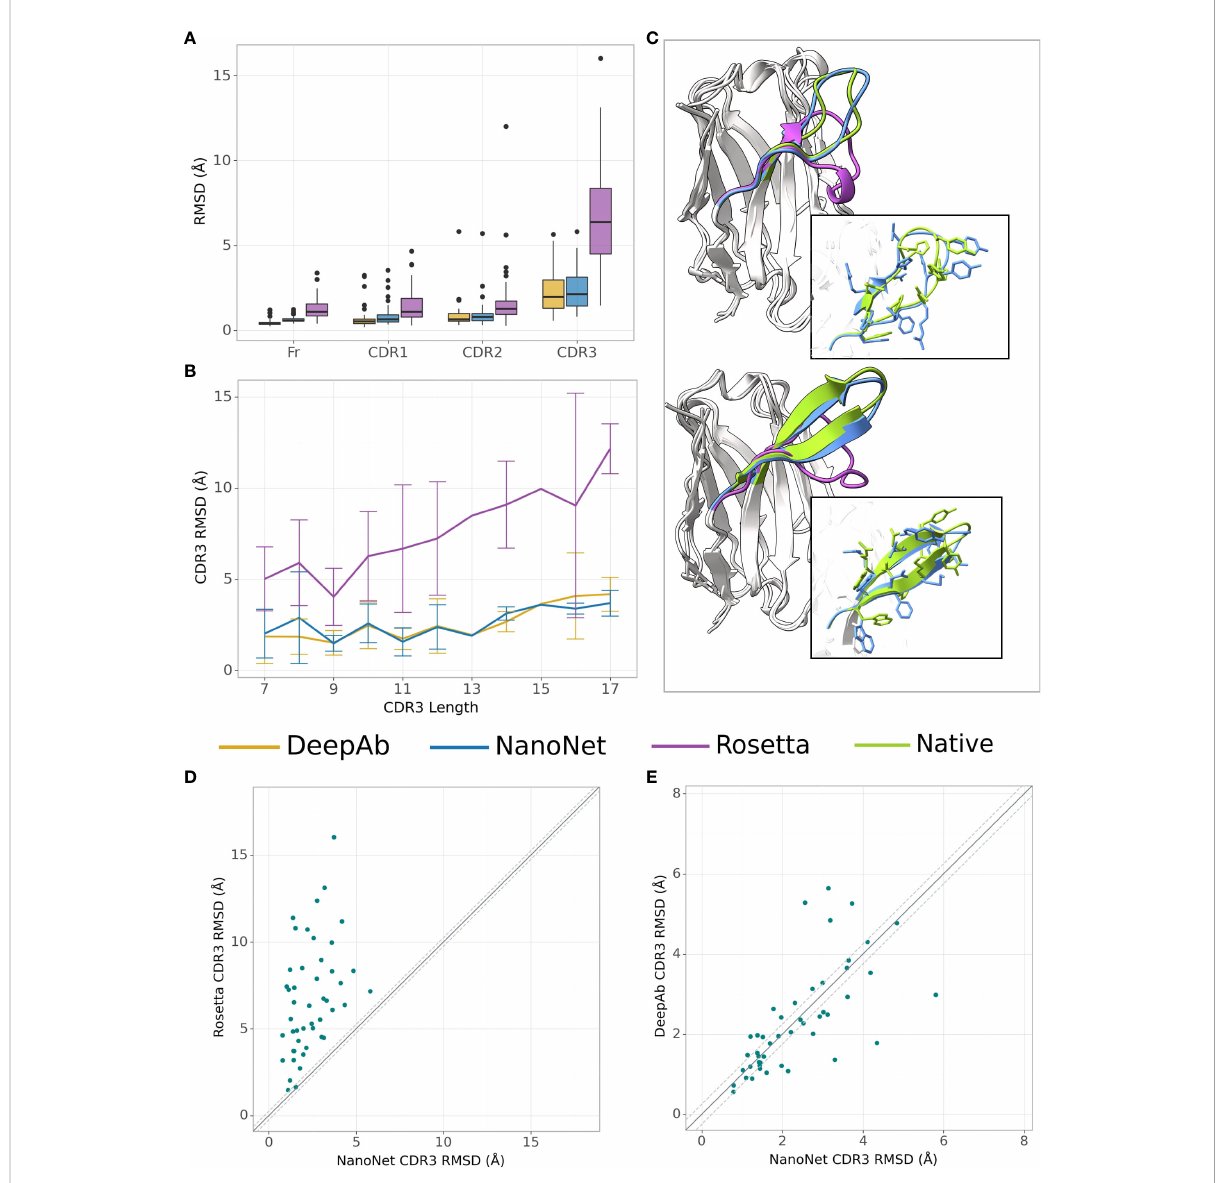
FIGURE 3 mAb VH modeling. (A) Boxplots of RMSDs of the framework, CDR1-3 loops for the mAbs test set (47 mAbs), (B) Average RMSD of CDR3 loop as a function of loop length on the mAbs test set (47 mAbs), (C) Test set examples of modeled structures by NanoNet (blue), RosettaAntibody (purple) vs. experimental (green): PDB 3t65 (top) and 1jfq (bottom), CDR3 RMSD 1.14Å and 1.02Å, for NanoNet, and 7.24Å and 7.42Å for RosettaAntibody, respectively, (D) CDR3 loop RMSD for NanoNet vs. RosettaAntibody, each dot represents a structure from the test set. The dotted line corresponds to 0.25Å RMSD, (E) same as D for NanoNet vs.